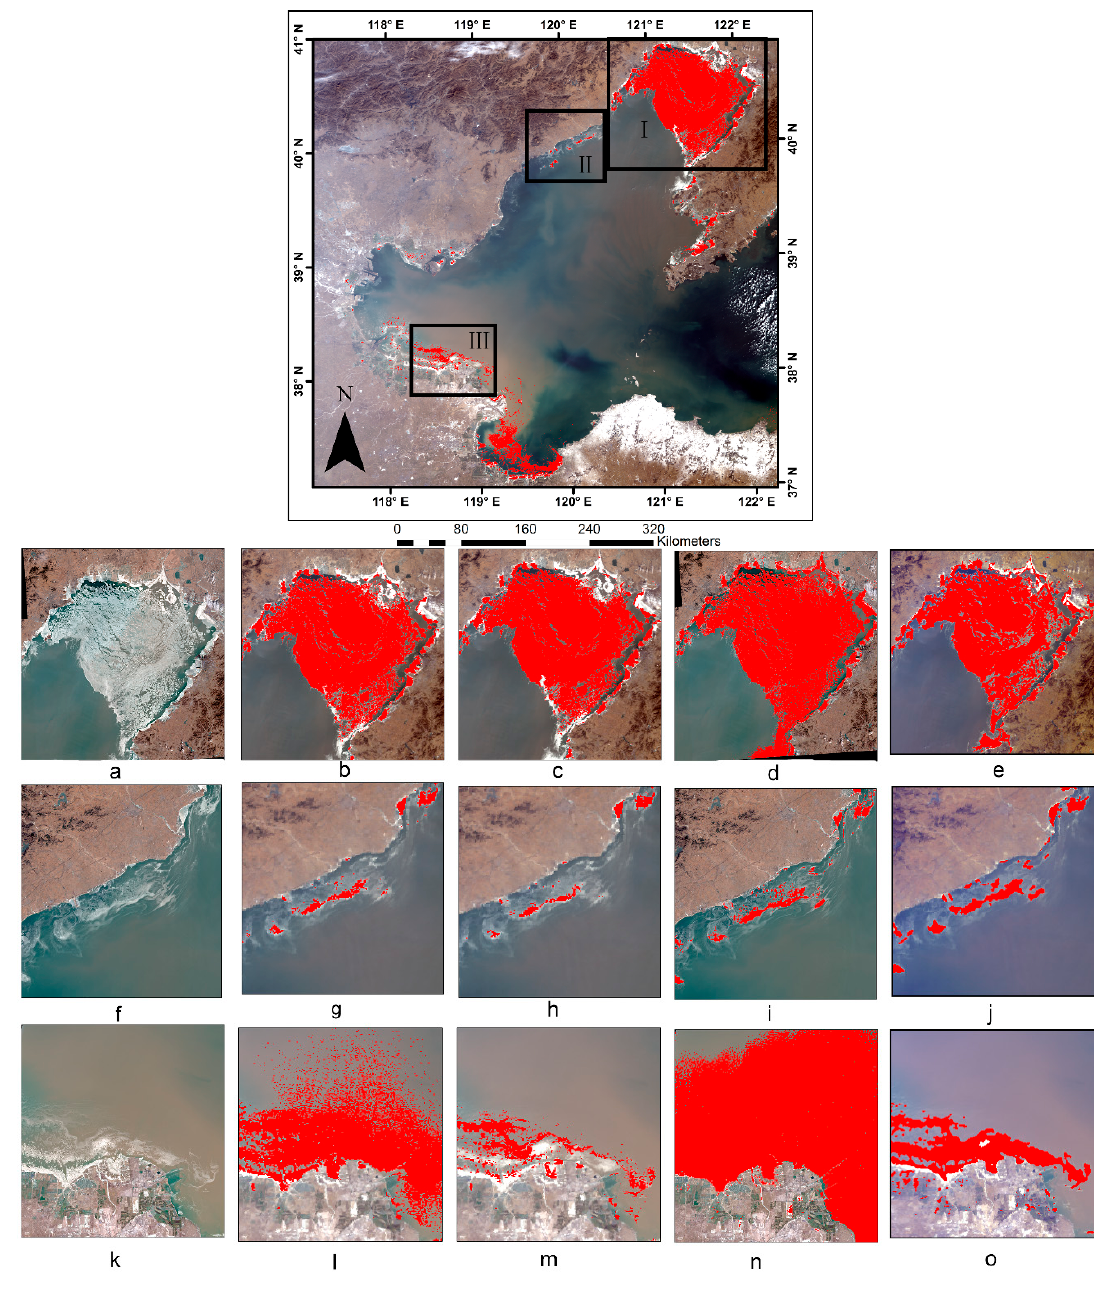
Figure 6. An image of sea ice extraction result for the entire Bohai Sea (top) on 1 February 2018 using threshold segmentation from ENDSIII OLCI . Three true-color images in the first column ( a , f , k ) are the enlarged MSI validation images indicated by boxes I, II, and III in the top image, respectively. The next four columns present the results of sea ice extent extraction using NDSIII OLCI ( b , g , l ), ENDSIII OLCI ( c , h , m ), NDSI ( d , i , n ), and SVM ( e , j , o ).